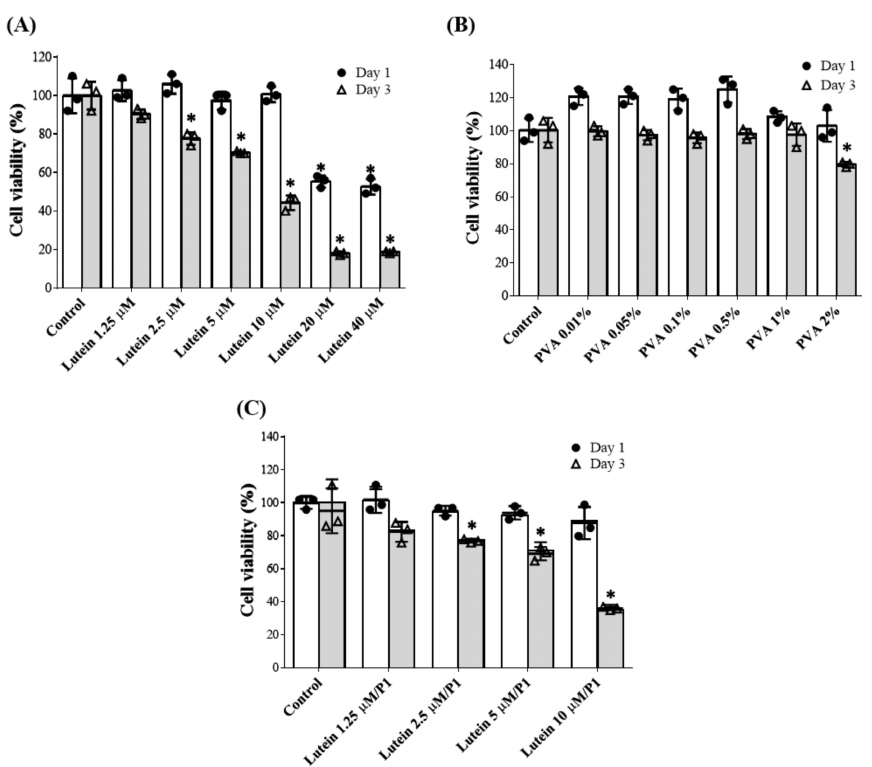
Figure 1. Cell viability of human corneal epithelial cells (HCE-2) upon coculture with varying concentrations of ( A ) lutein, ( B ) PVA, and ( C ) lutein/PVA combination for 1 and 3 days. Data are expressed as the mean ± standard deviation (SD) and analyzed by one-way ANOVA test; n = 6, (* p < 0.05 compared with the control group). P1: 1% PVA.